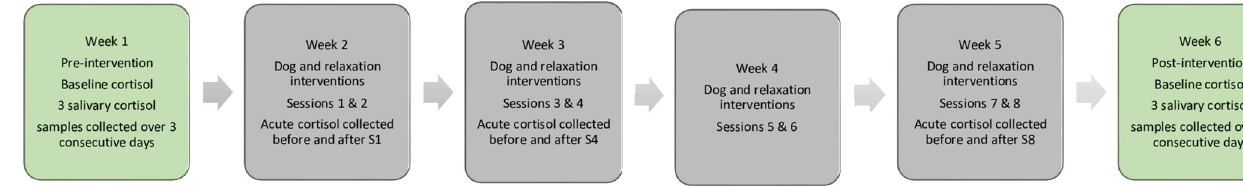
Fig 1. Timeline in overview. Timeline for collection of salivary cortisol samples, and timing of interventions.